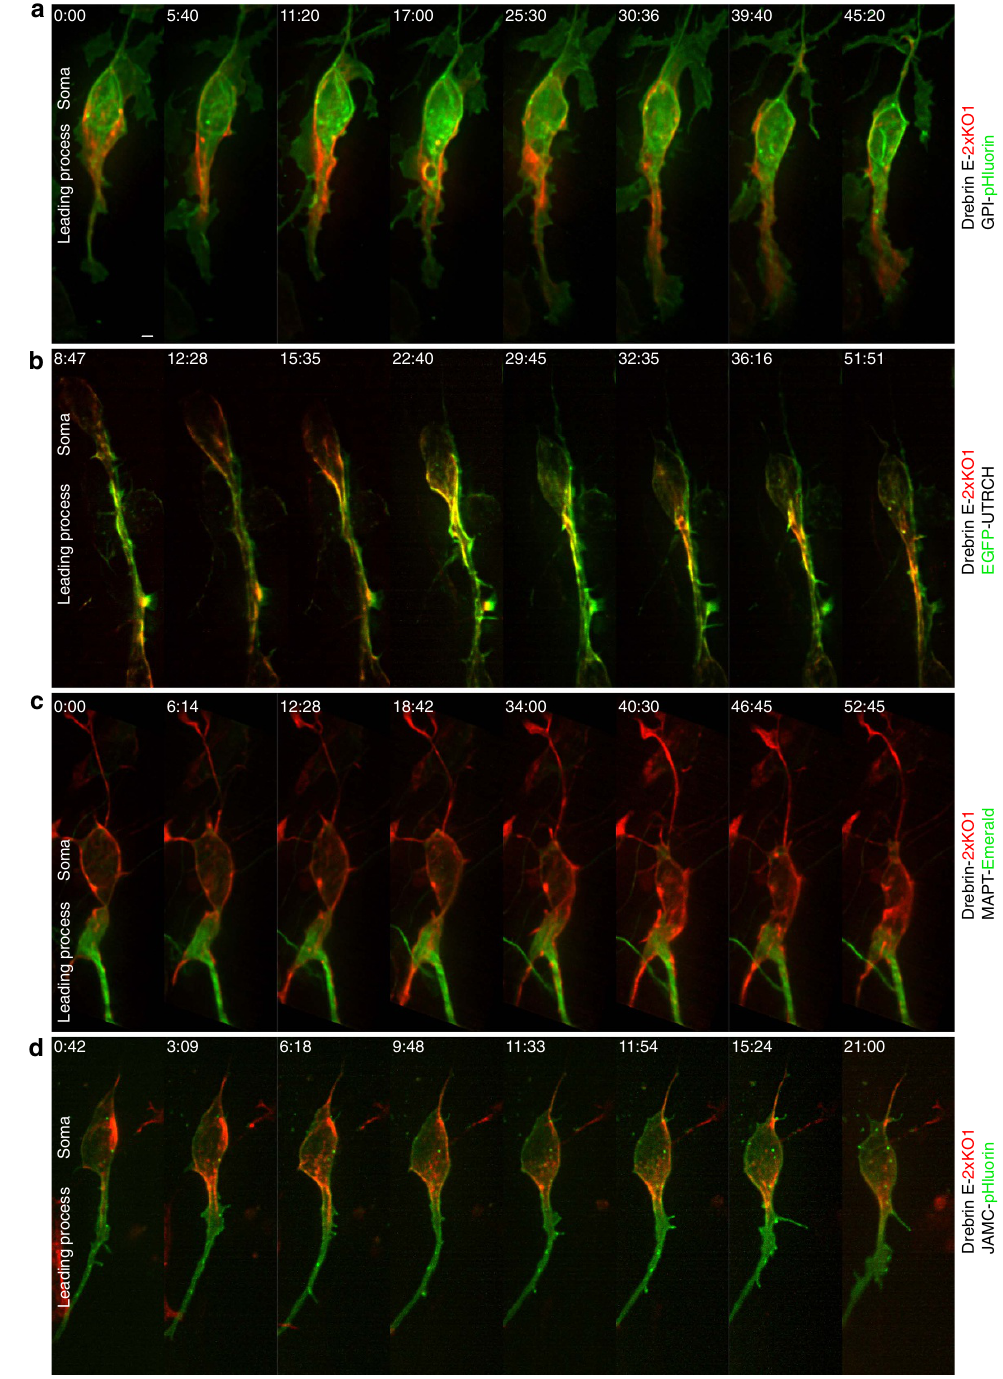
Figure 2 | LLS microscopy reveals unappreciated relationships between cytoskeleton and plasma membrane in the proximal leading process. CGNs cultured in conditions that recapitulate radial migration were electroporated with expression vectors encoding the indicated fluorescently labelled live-cell imaging probes. The displayed images are maximum intensity projections of selected time points of cultures imaged via LLS microscopy 18–24h post transfection. Scale bar, 2 m m. ( a ) Simultaneous imaging of plasma membrane (GPI-pHluorin, green) and drebrin (labelled with drebrin E 2x-KO1, red) reveals that drebrin is submembranous during its anterograde translocation. ( b ) f-Actin (labelled with EGFP-UTRCH, green) accumulates in the leading process before somal translocation. Initially, drebrin (labelled with drebrin E 2x-KO1, red) is localized mostly in the cell body but becomes restricted to the leading process f-actin domain. ( c ) Debrin (labelled with drebrin E 2x-KO1, red) accumulates around microtubules located in a well-dilated proximal leading process (labelled with MAPT-Emerald, green) before somal translocation. Note that drebrin appears to be more cortically restricted than the microtubules. ( d ) Simultaneous imaging of JAM-C adhesions (JAM-C-pHluorin, green) and drebrin (labelled with drebrin E 2x-KO1, red) reveals that a subset of JAM-C adhesions are located in the drebrin contractile domain. Scale bar, 2 m m ( a ). Time stamp ¼ min:sec.